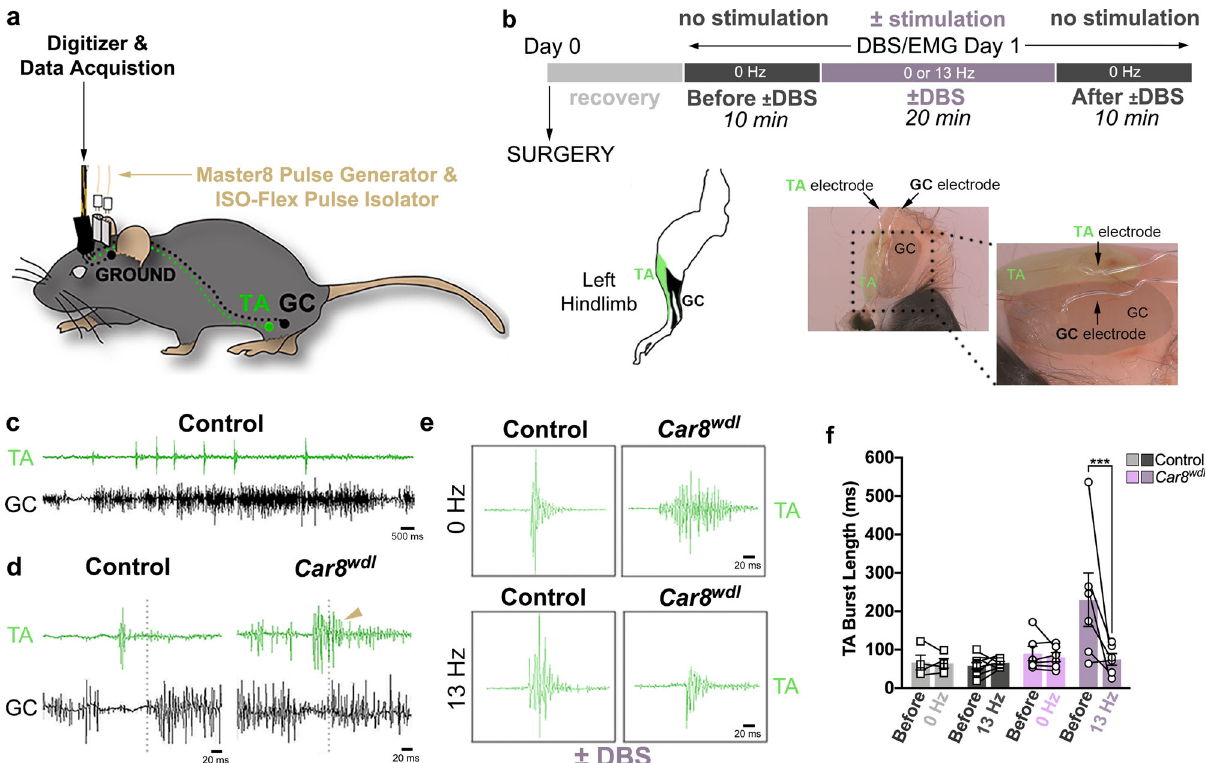
Fig. 2 13 Hz DBS delivered to the Car8 wdl cerebellum improves TA muscle activity. a Schematic of the surgery that combines DBS with EMG. Mouse was adapted from Miterko et al. (http://creativecommons.org/licenses/by/4.0/) 25 . b Experimental timeline of the DBS/EMG surgery and stimulation/ recording paradigm. EMG electrodes correctly target the tibialis anterior (TA) and gastrocnemius (GC) hindlimb muscles. c An example EMG trace of a control mouse during locomotion. d Example EMG traces of control and mutant mice before cerebellar stimulation. Prolonged contractions of the TA muscle occur in Car8 wdl mice and causes a co-contraction with the GC muscle. Dotted lines denote the start of a GC contraction. The yellow arrow points to an example of a co-contraction. e Examples of TA contractions in non-stimulated and stimulated control and mutant mice. DBS delivered at a frequency of 13 Hz shortens TA contractions in Car8 wdl mice. f Quanti fi cation of TA burst length reveals that 13 Hz DBS signi fi cantly shortens the muscle contraction time of Car8 wdl mice ( p = 0.0005). n = 24 biologically independent animals (Control: 0 Hz, n = 4, 13 Hz, n = 8; Car8 wdl : 0 Hz, n = 6, 13 Hz, n = 6) over 24 independent experiments. *** p < 0.001; three-way ANOVA, repeated measures; Sidak ’ s multiple comparisons test; mean ±